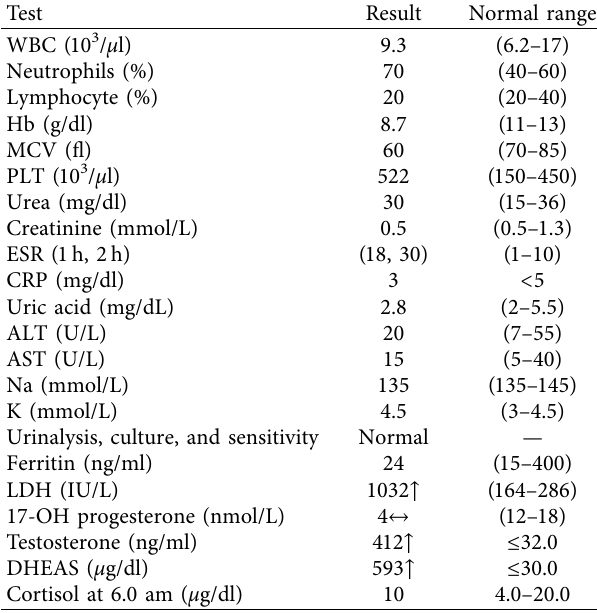
Table 1: The laboratory data of the case.